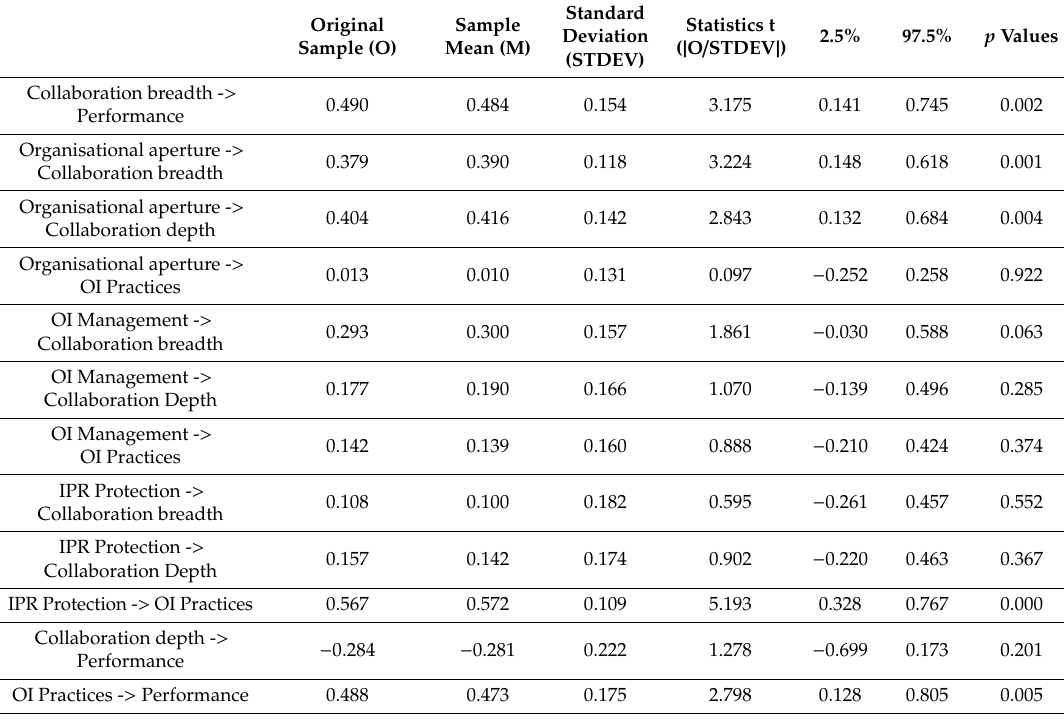
Table 13. Structural model relationships.